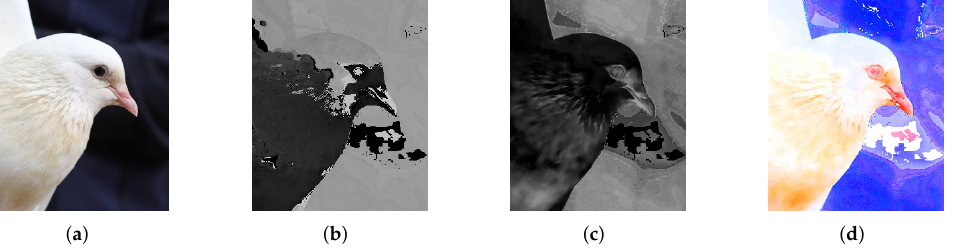
Figure 5. Extract color distribution information. ( a ) Original image. ( b ) Hue channel. ( c ) Saturation channel. ( d ) Color distribution